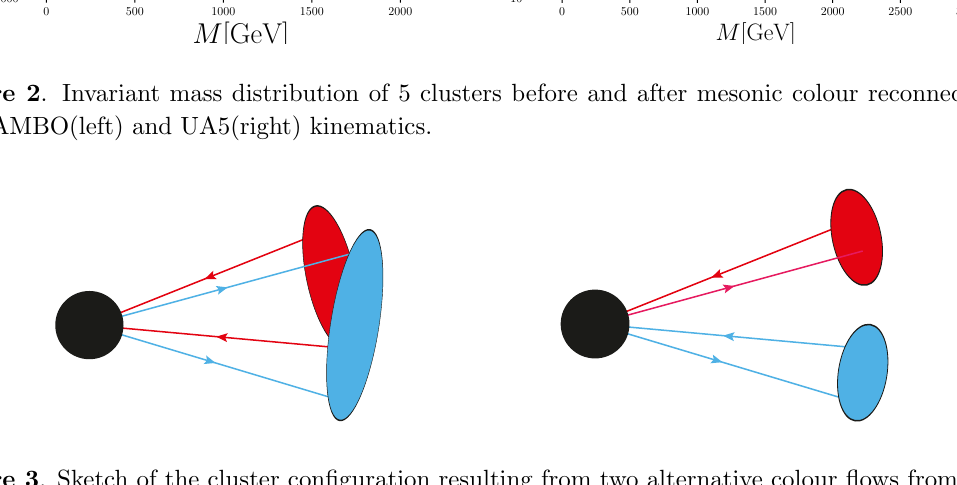
Figure 3 . Sketch of the cluster con(cid:12)guration resulting from two alternative colour (cid:13)ows from two cluster evolution. The left (cid:12)gure shows two large overlapping clusters and the right (cid:12)gure shows a di(cid:11)erent colour (cid:13)ow resulting in smaller clusters consisting of quark anti-quark pairs closer in momentum space. The black blob can be associated with an interaction or parts of an interaction that would lead to the shown